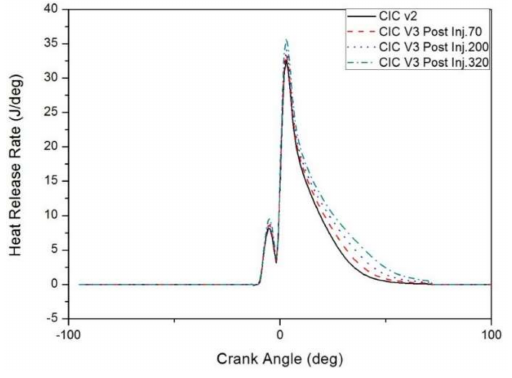
Figure 12. Heat release rate traces for different recompression strategies with three post injections.